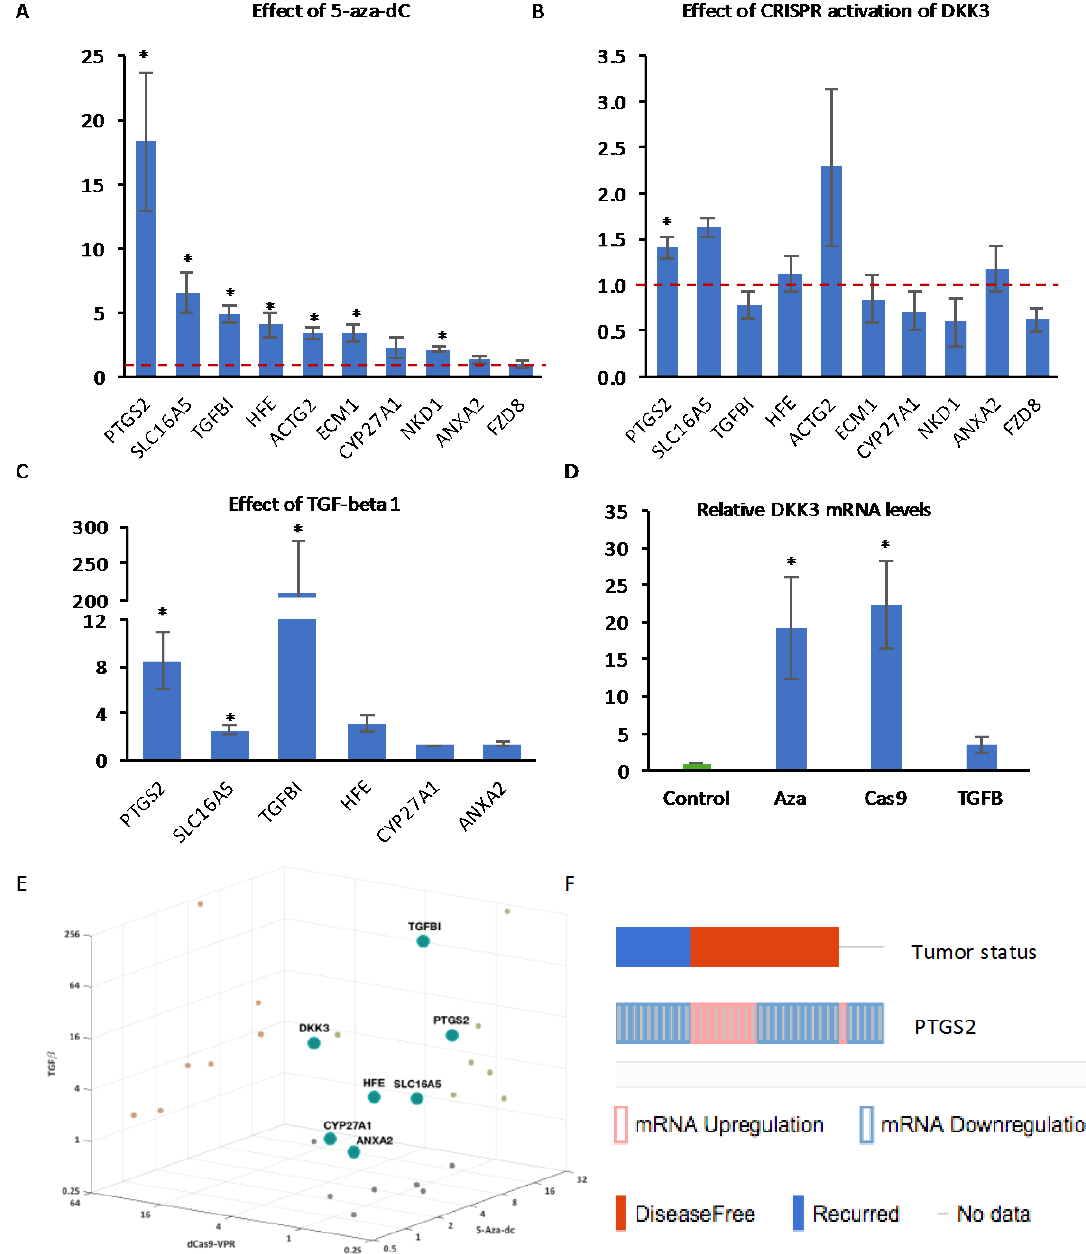
Figure 7. Q-RT-PCR analysis of the expression of the indicated genes in PC3 cells ( A ) treated with 5_Aza-dC for 72 h, ( B ) transfected with dCas9-VPR and control gRNA or DKK3 gRNAs for 48 h and ( C ) treated with TGF-β1 for 24 h. ( D ). Q-RT-PCR analysis of the expression of DKK3 in PC3 cells under the indicated conditions. Graphs show mean expression relative to control (dashed red lines indicate control level set to 1) ± SD, n = 3 to 5, * p < 0.05 two-tailed Student’s t -test. ( E ) 3D plot illustrating the effects of decitabine, CRISPR induction of DKK3 and TGF-β1 on the indicated genes. ( F ) Comparison of tumors with changes in PTGS2 expression (up, red; down, blue) and disease-free status of patients, from cBioPortal using the MSKCC 2010 dataset [45].